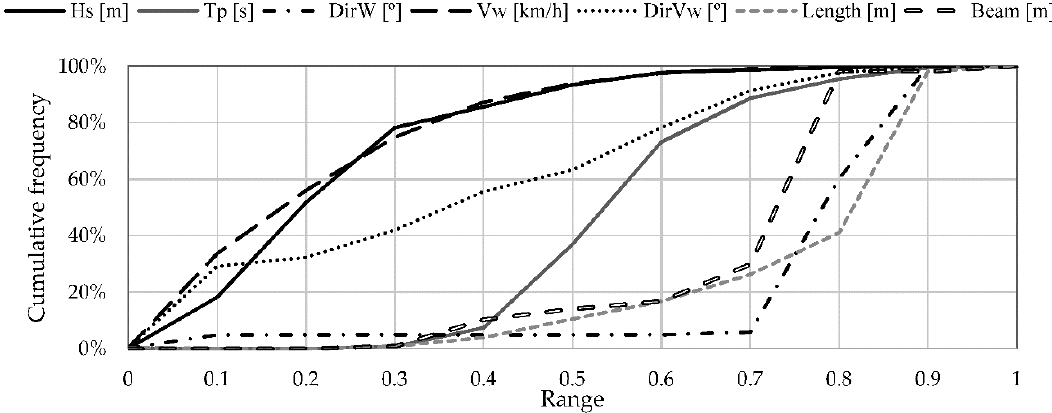
Figure 6. Cumulative frequency distribution of each of the recorded variables (Dimensionless variable range (Variable value (i) / Maximum variable value) vs. Accumulated frequency for each of the variables).